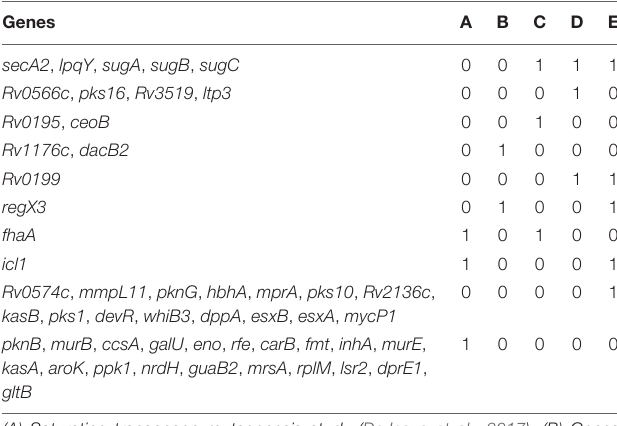
TABLE 3 | List of biofilm- and quorum sensing-associated proteins (BQAPs) implicated in essentiality and/or virulence. Genes A B C D